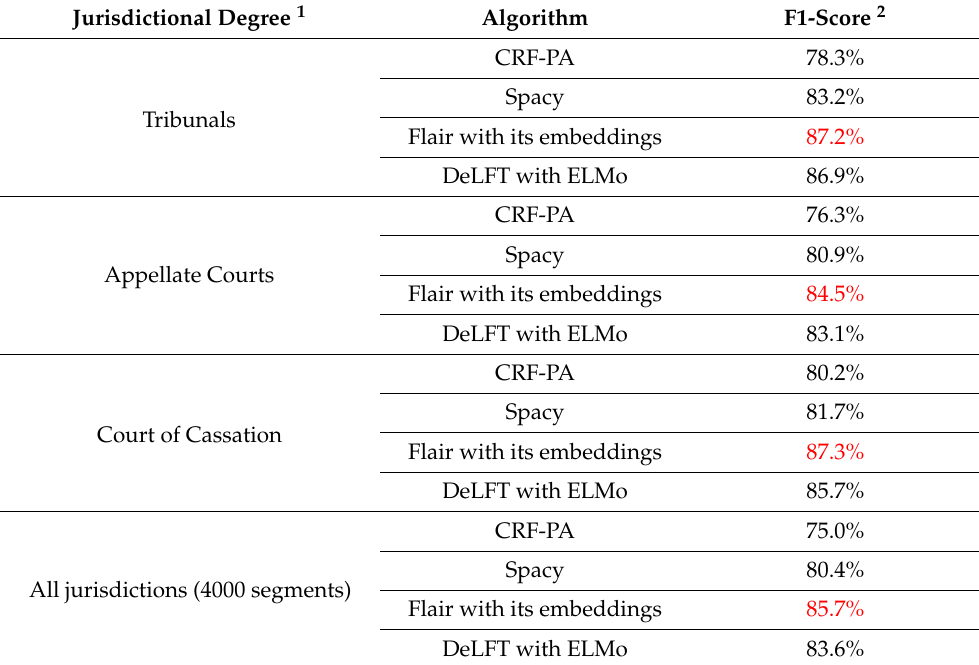
Table 7. Quality by jurisdictional degree.